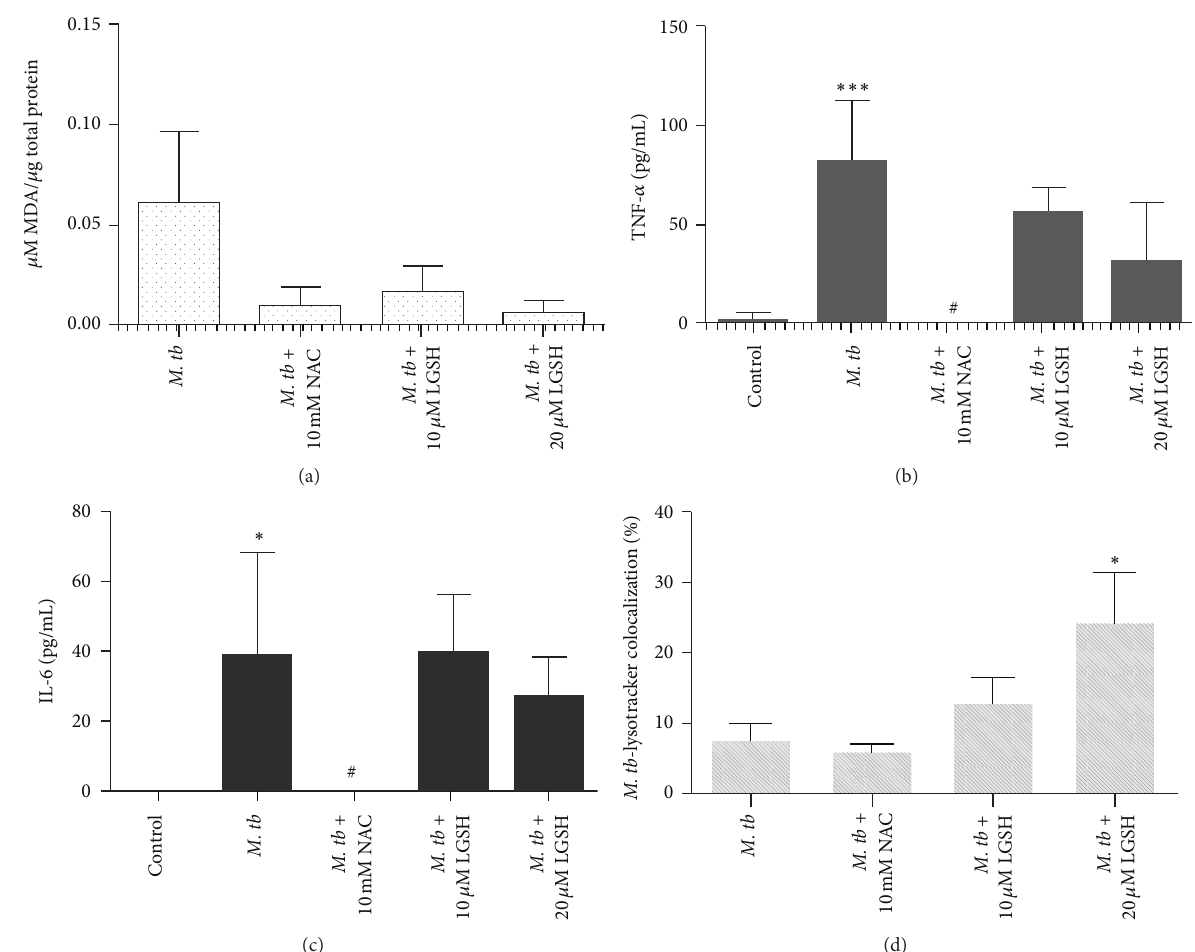
Figure 4: Assay of MDA in neutrophil lysates at 24 hours after infection with H37Rv ( 𝑛 = 5 ). Free radical levels in neutrophil lysates were determined by measuring thelevels ofMDAusinga colorimetricassay kitfromCayman. Theseelevated MDAconcentrations areindicative of elevated free radical concentrations. Treatment with either NAC or L - GSH reduced the amount of MDA. (b) and (c): Cytokine measurements performed in supernatants derived from H37Rv-infected neutrophils . Levels of TNF- 𝛼 (b) and IL-6 4(c) in neutrophil supernatants were measuredbyELISA.(d):DeterminationofphagosomeacidificationbyquantifyingthecolocalizationofFITC-labeledH37Rvwithlysotracker: neutrophils were stained with lysotracker and infected with FITC labeled H37Rv. Infected neutrophils were incubated for 24 hours on sterile glass cover slips in the presence and absence of GSH-enhancing agents. Neutrophils were fixed with 3.8% PFA in PBS for 30 minutes, and the coverslips were mounted on a clean glass slide using DAPI. Slides were then viewed using an inverted fluorescent microscope for the colocalization of FITC-labeled H37Rv with lysotracker which is indicative of phagosome acidification. Images were obtained using an integrated digital camera and analyzed using ImageJ. ∗∗∗ 𝑃 ≤ 0.001 ; # 𝑃 ≤ 0.05 . Graph shows mean ± standard